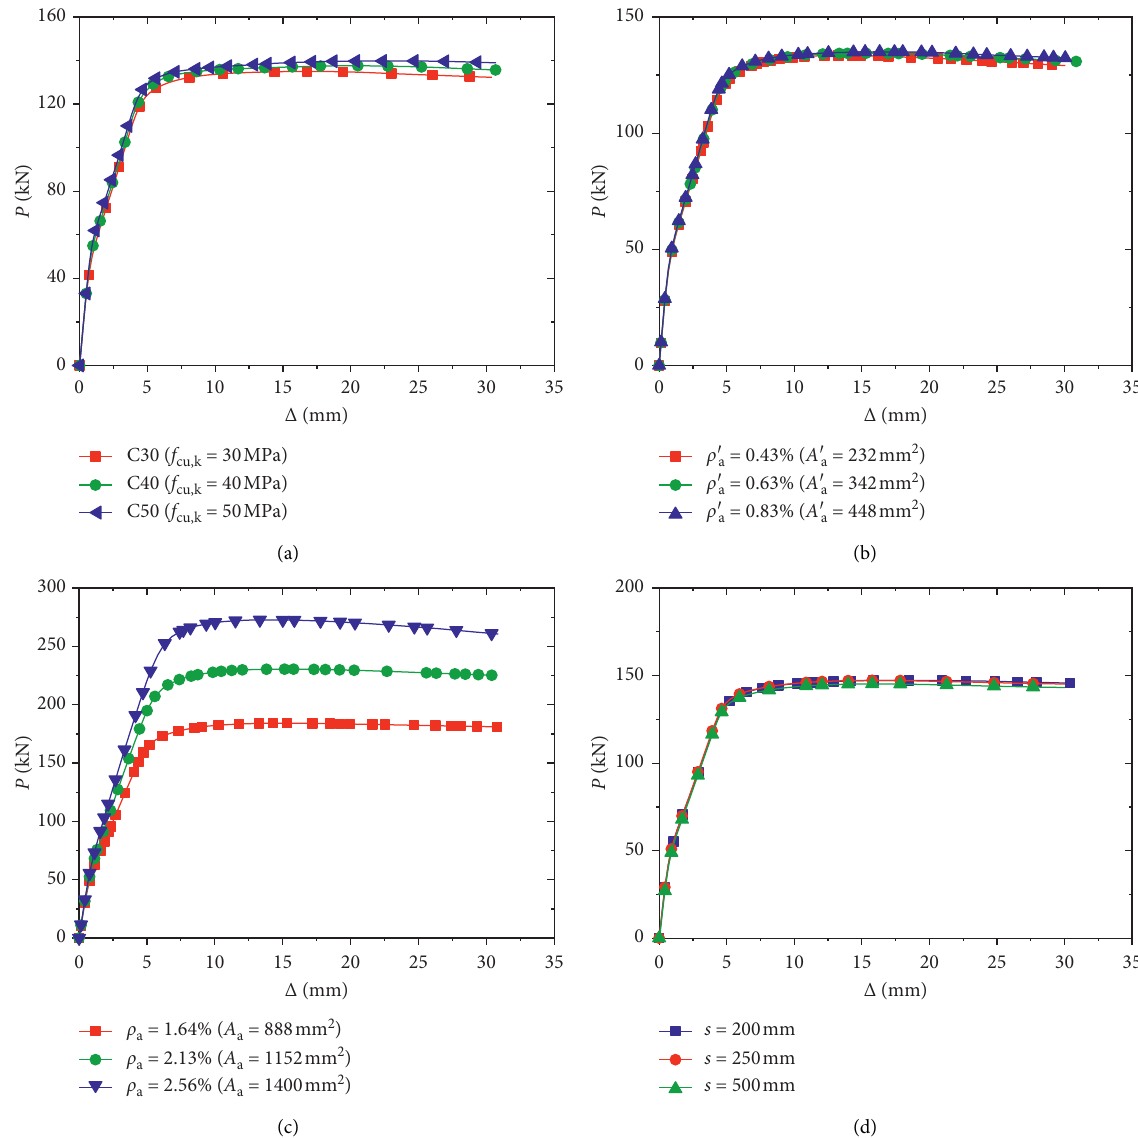
Figure 8: Influence of different parameters on load-deflection curves. (a) Concrete strength grade. (b) Steel ratio of steel tube of upper chords. (c) Steel ratio of steel tube of lower chords. (d) Truss joint